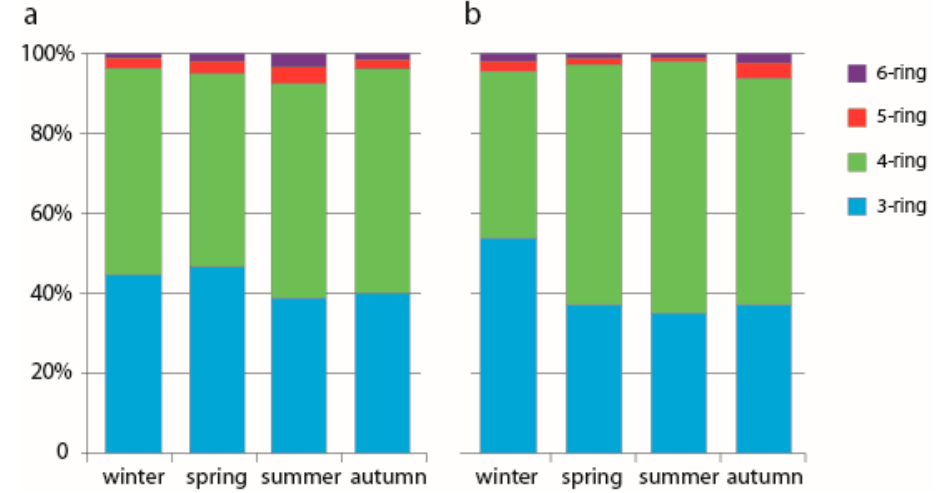
Figure 3. The percent composition of 3-, 4-, 5-, and 6-ring TPAHs in different seasons in waters of the Tumen River estuary ( a ) and the Partizanskaya River estuary ( b ).